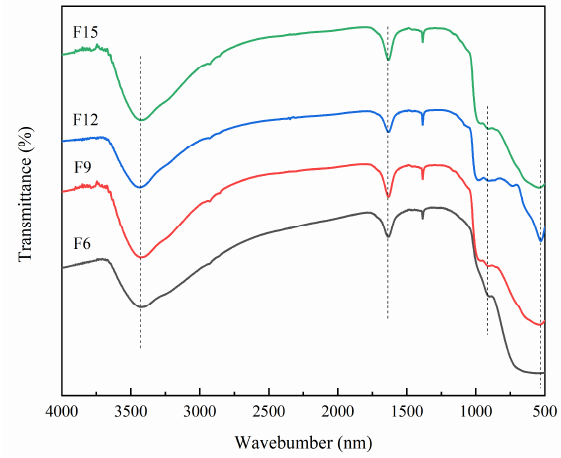
Figure 5. FT-IR diagram of FX .